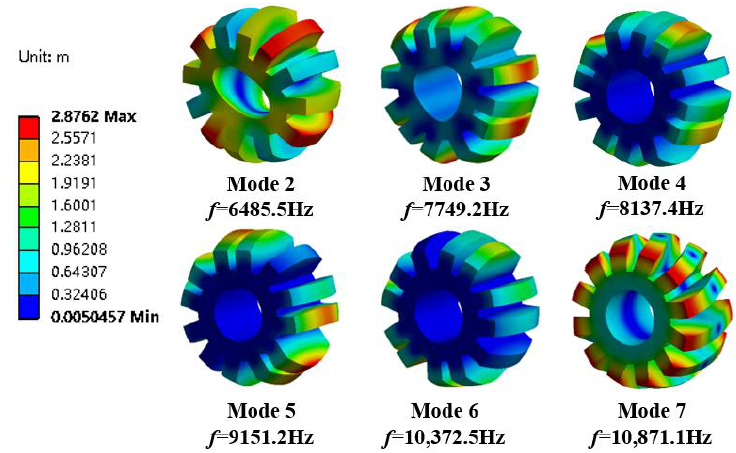
Figure 17. Internal stator modal analysis cloud diagram.